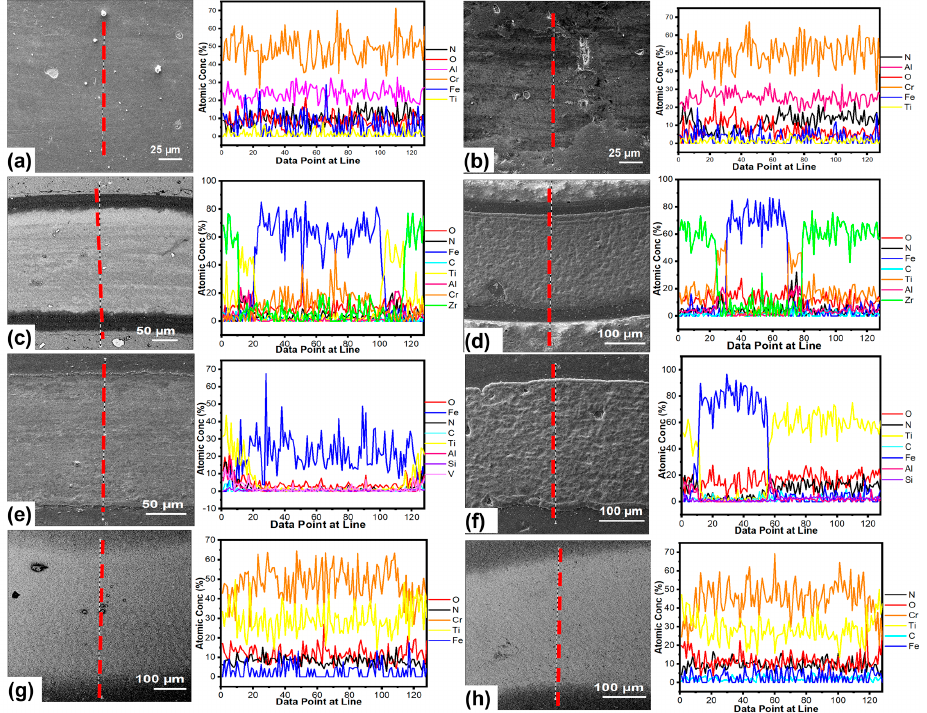
Figure 10. ( a ) Wear rates of the coatings at 20 °C, ( b ) wear rates of the coatings at 700 °C, ( c ) wear rates of the ball at 20 ◦ C, ( d ) wear rates of the ball at 700 ◦ rates of the ball at 20 °C, ( d ) wear rates of the ball at 700 °C. Table 4. Wear rate and wear depth of coatings.